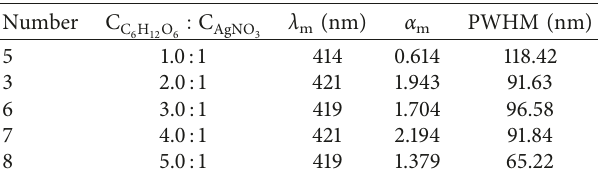
Table 2: Test results of AgNPs synthesized under different glucose